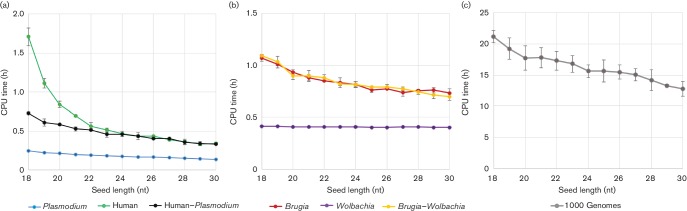
CPU time for all bwa-mem datasets. The mean and sd of CPU time in hours for each of three replicate alignments is plotted against each seed length for a subset of datasets. In the two dual-species data sets, the sequencing reads were aligned to the reference genome of each species separately, as well as a combined reference of both genomes. The 1000 Genomes dataset was only aligned to the human reference genome.